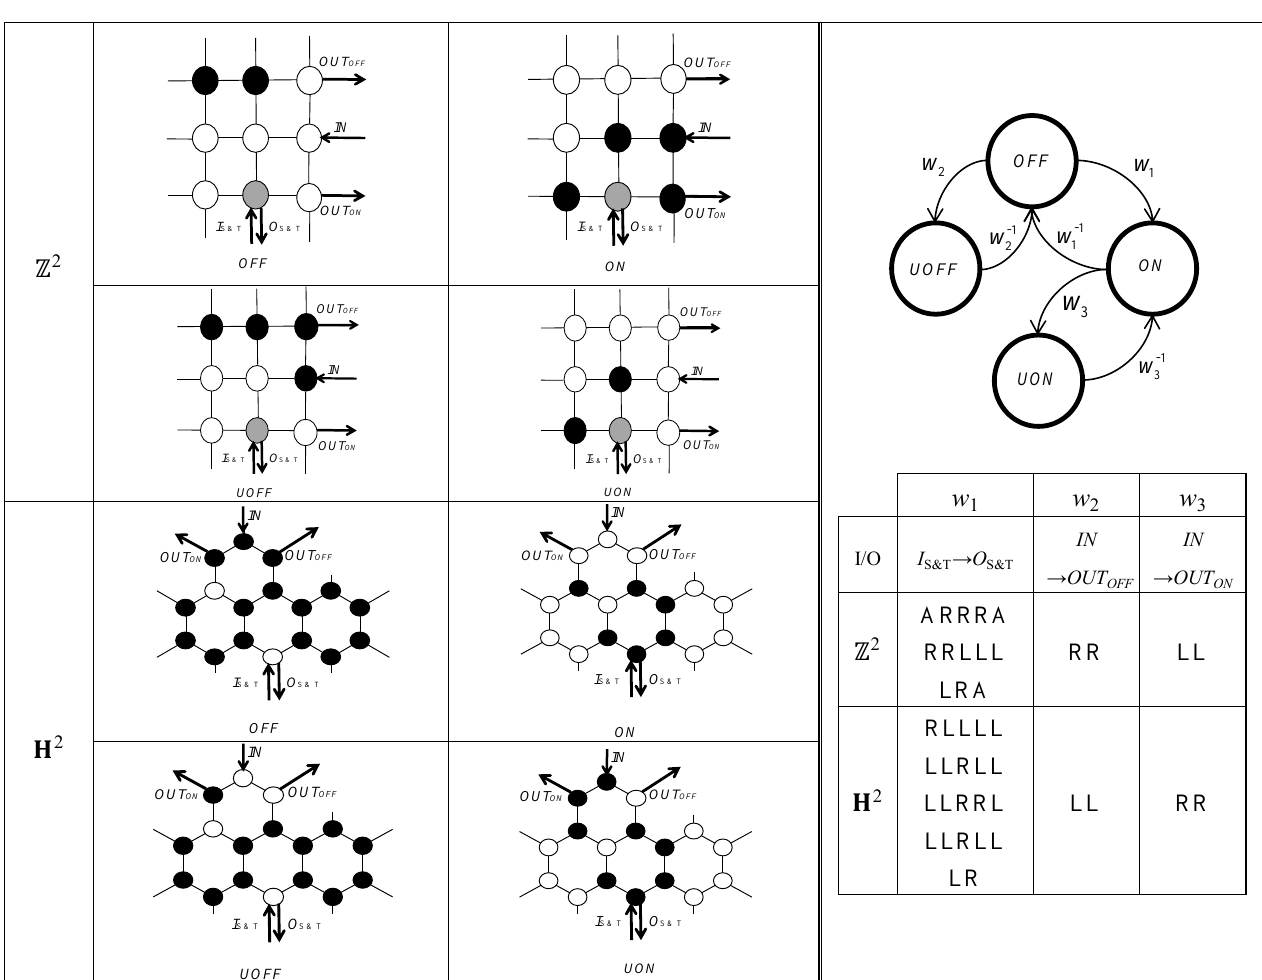
Figure 7. Switch & Turn.